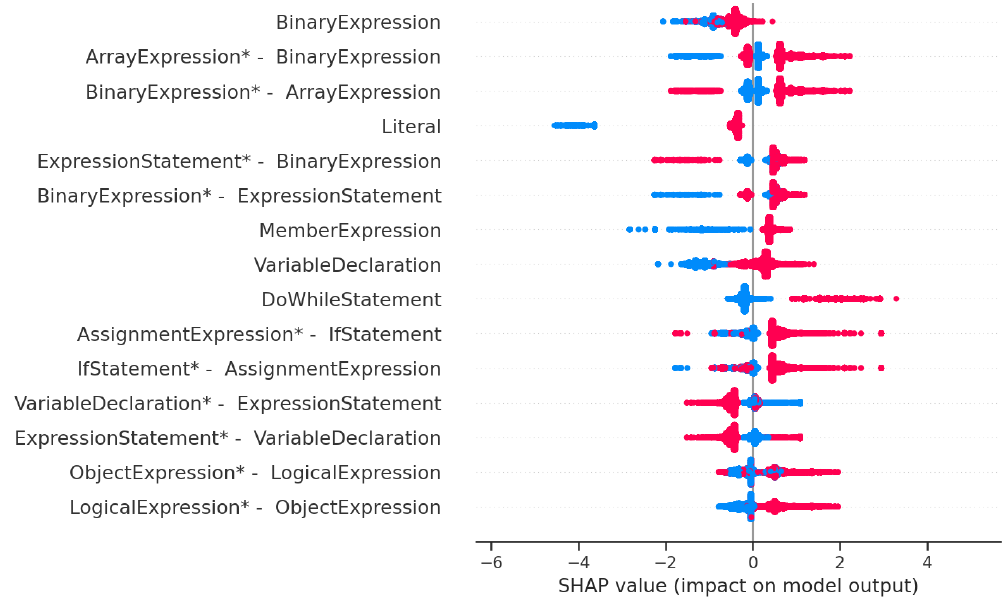
Figure 6. SHAP interaction values. * represents AST-JS feature